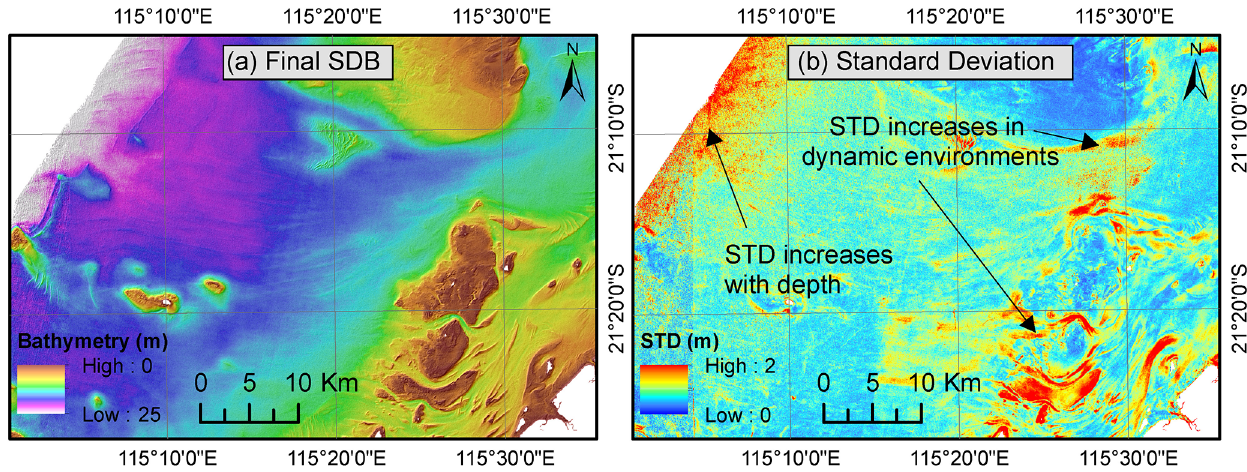
Figure 12. Illustration of the standard deviation grid (b) generated with the final SDB bathymetry (a) . The grid illustrates the spatial variability in the final SDB grid accuracy. The standard deviation increases (and hence the accuracy of the bathymetry decreases) with depth as well as in dynamic environments where the seabed changed through the sensing period such as by tidal passes (b) . For data sources, see Sect. 5.2.1. Table 3. Accuracy of the datasets included in the regional DEM. DEM Satellite-derived Seismic-derived MBES SRTM AusBathyTopo